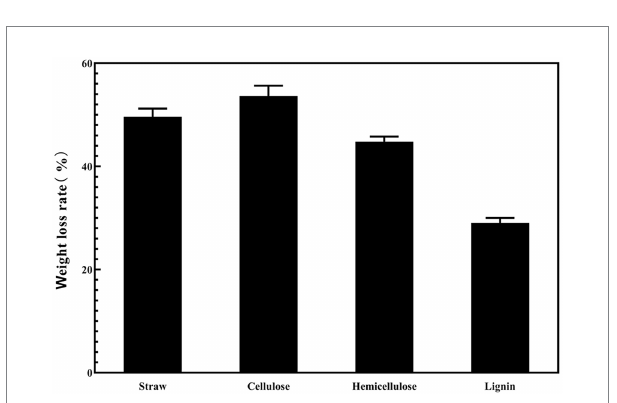
FIGURE 5 The weight loss rate of the different components in rice straw under the condition of ZJW-6.